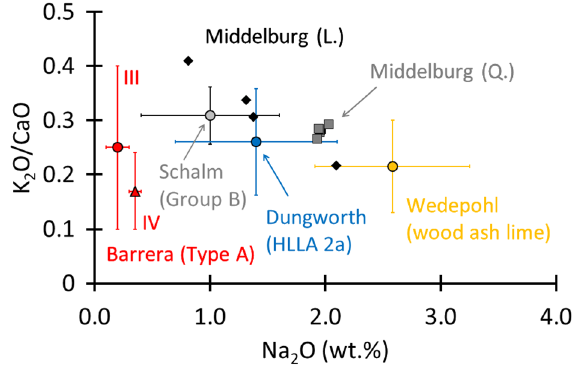
Figure 5. Plotting the Na 2 O concentration against the K 2 O/CaO ratio shows that all groups have comparable K 2 O/CaO ratios but deviating soda levels. Considering all groups with a fifteenth century assignment shows that the lozenge group (filled diamond) best matches Group B of Schalm. The same exercise used for the quadrangular group (filled square), unveils some overlapping behaviour with the German wood ash lime that Wedepohl researched, as well as the British HLLA 2a material that Dungworth described.